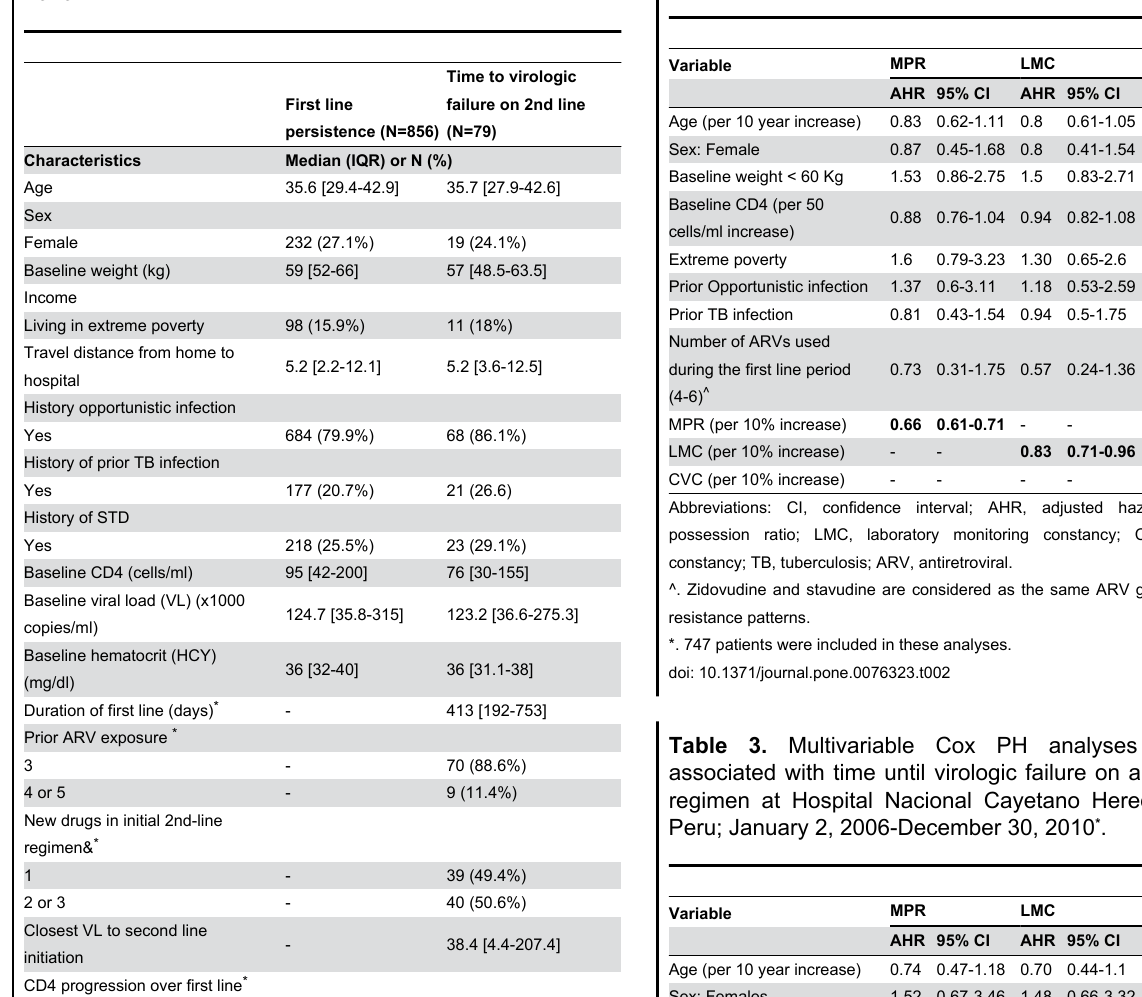
Table 2. Multivariable Cox PH analyses of factors associated with time to switch to a second line regimen among antiretroviral-naive patients starting Initial ART Regimens at Hospital Nacional Cayetano Heredia in Lima, Peru; January 2, 2006-December 30, 2010 * .